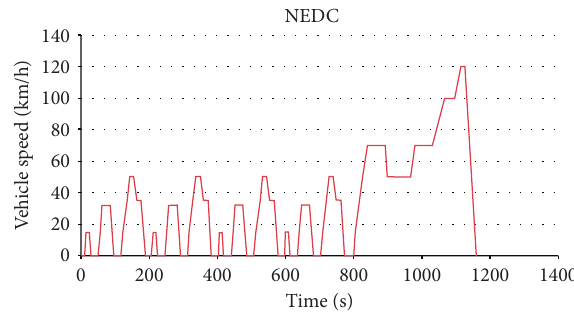
Figure 1: New European driving cycle